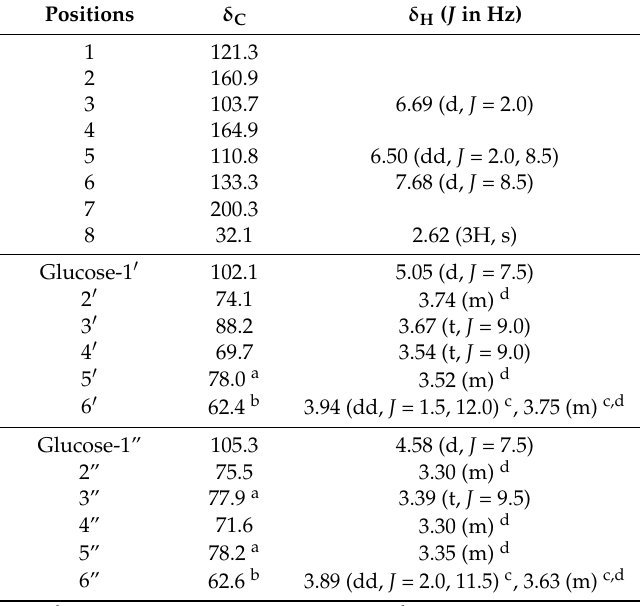
Table 1. 1 H- (500 MHz) and 13 C-NMR (126 MHz) data of compound 1 measured in MeOH- d 4 . Positions δ